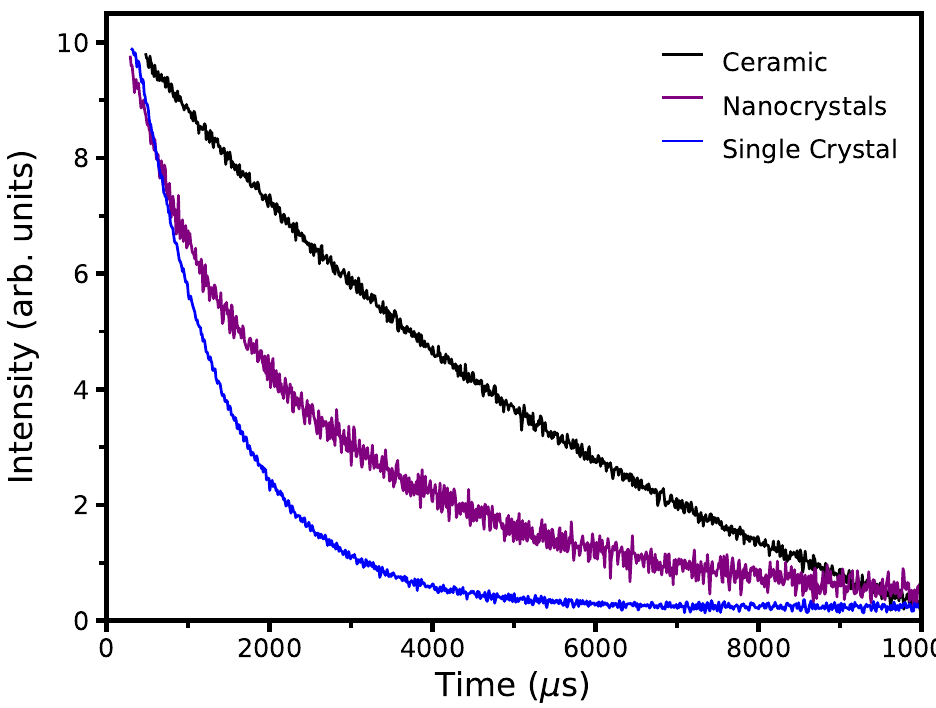
Figure 5. Fluorescence decay times for the 1650 nm emissions of all three samples excited at 525